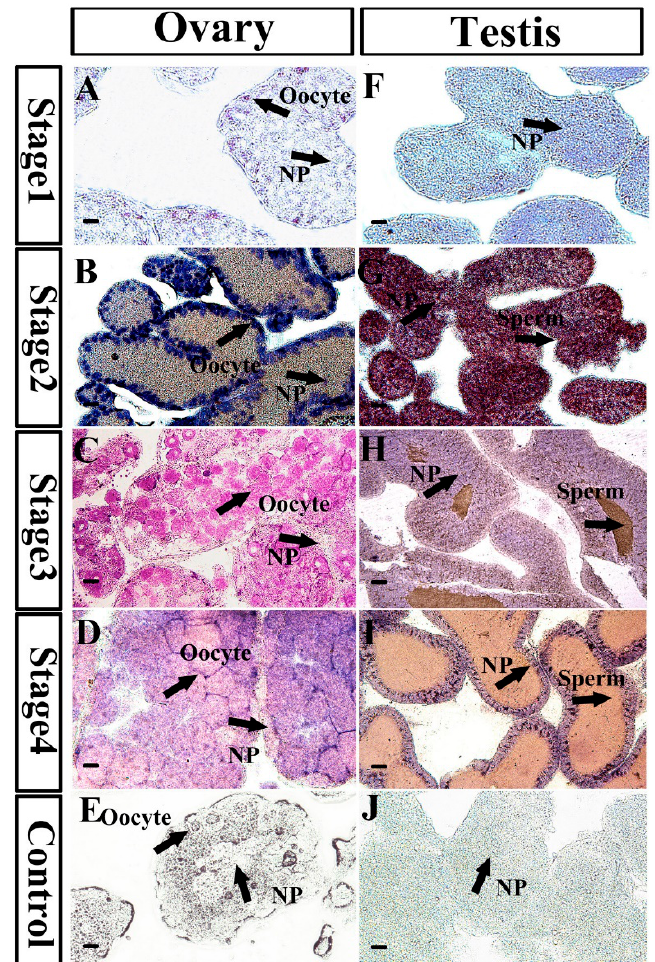
Figure 4. Mnnanos2 expression analysis by in situ hybridization in gonads at different gonadal development stages. ( A – E ) ovary, ( F – J ) testis. NP: nutritive phagocytes. Bar = 100 µm.